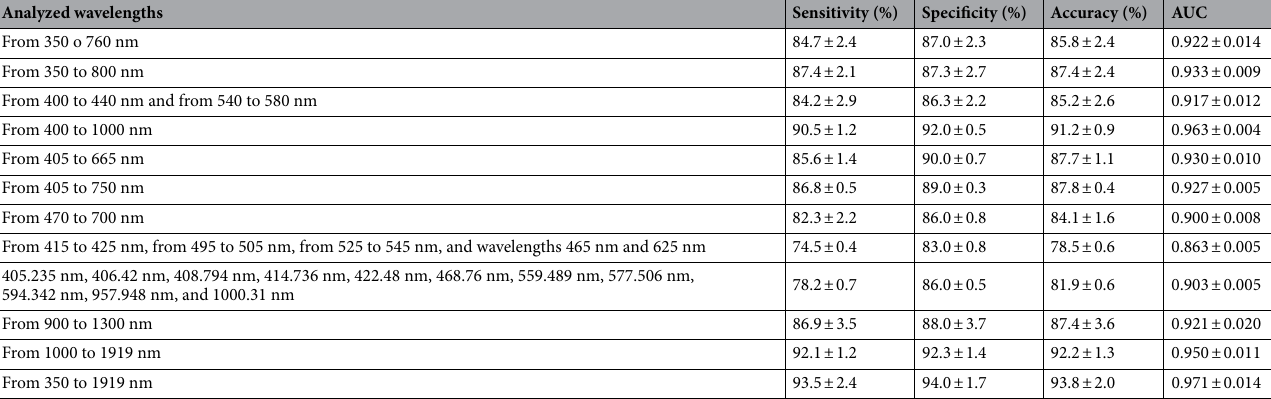
Table 4. Performance metrics of each wavelength range analyzed using the quadratic SVM classifier on the dataset of the small SDD